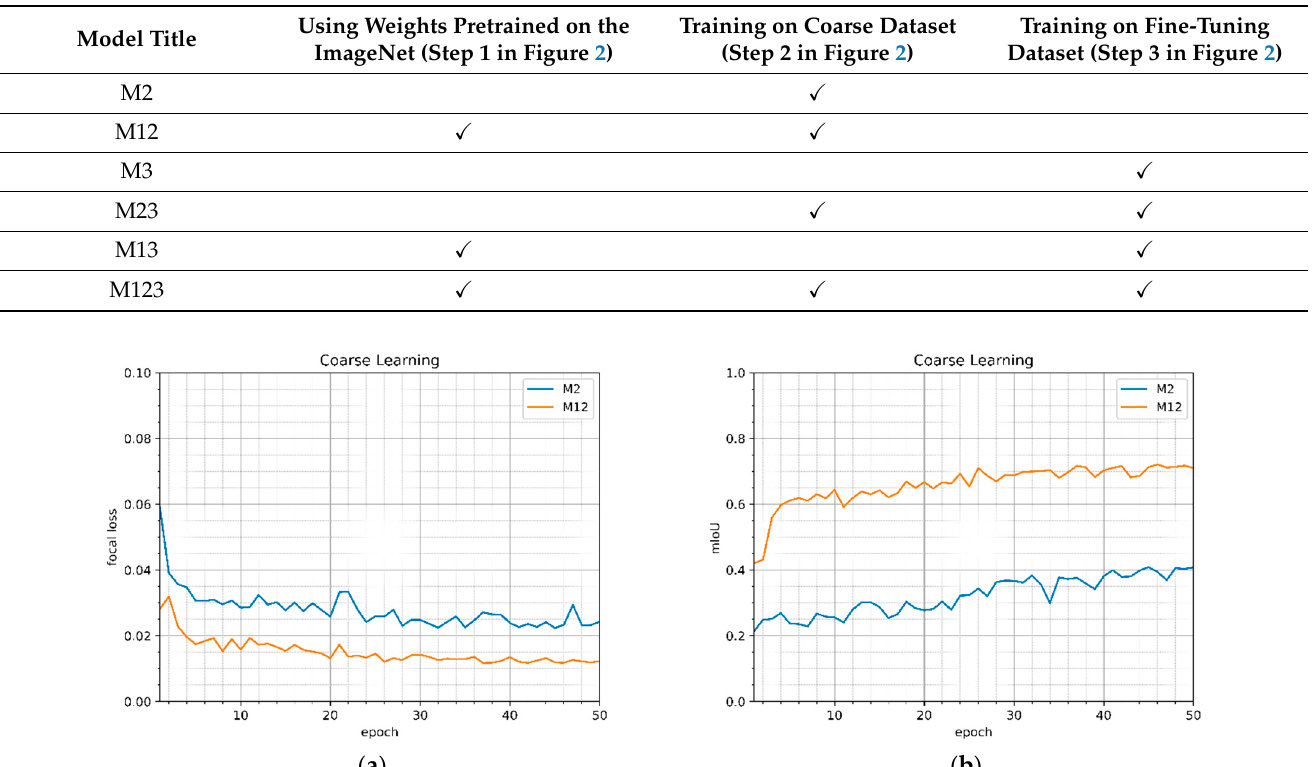
Table 1. Summarized strategies used in training models.